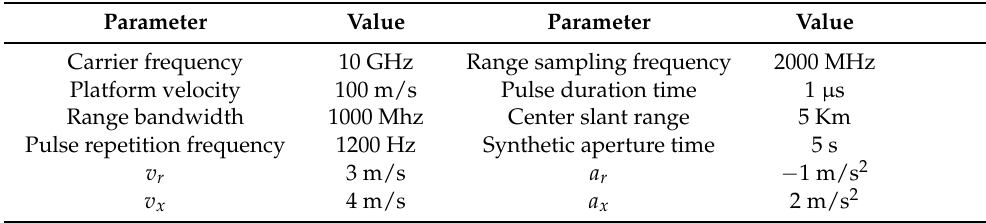
Table 2. Simulation parameter. Parameter Value Parameter Value Carrier frequency 10 GHz Range sampling frequency 2000 MHz Platform